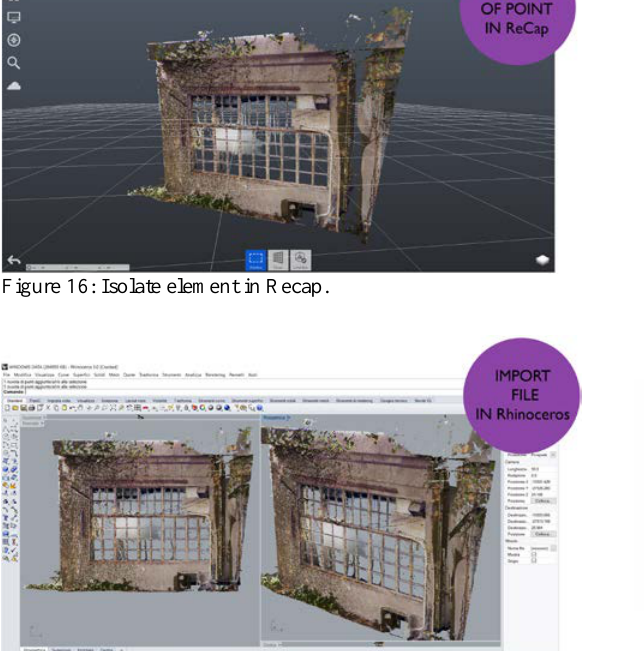
Figure 17: Element in Rhinoceros.